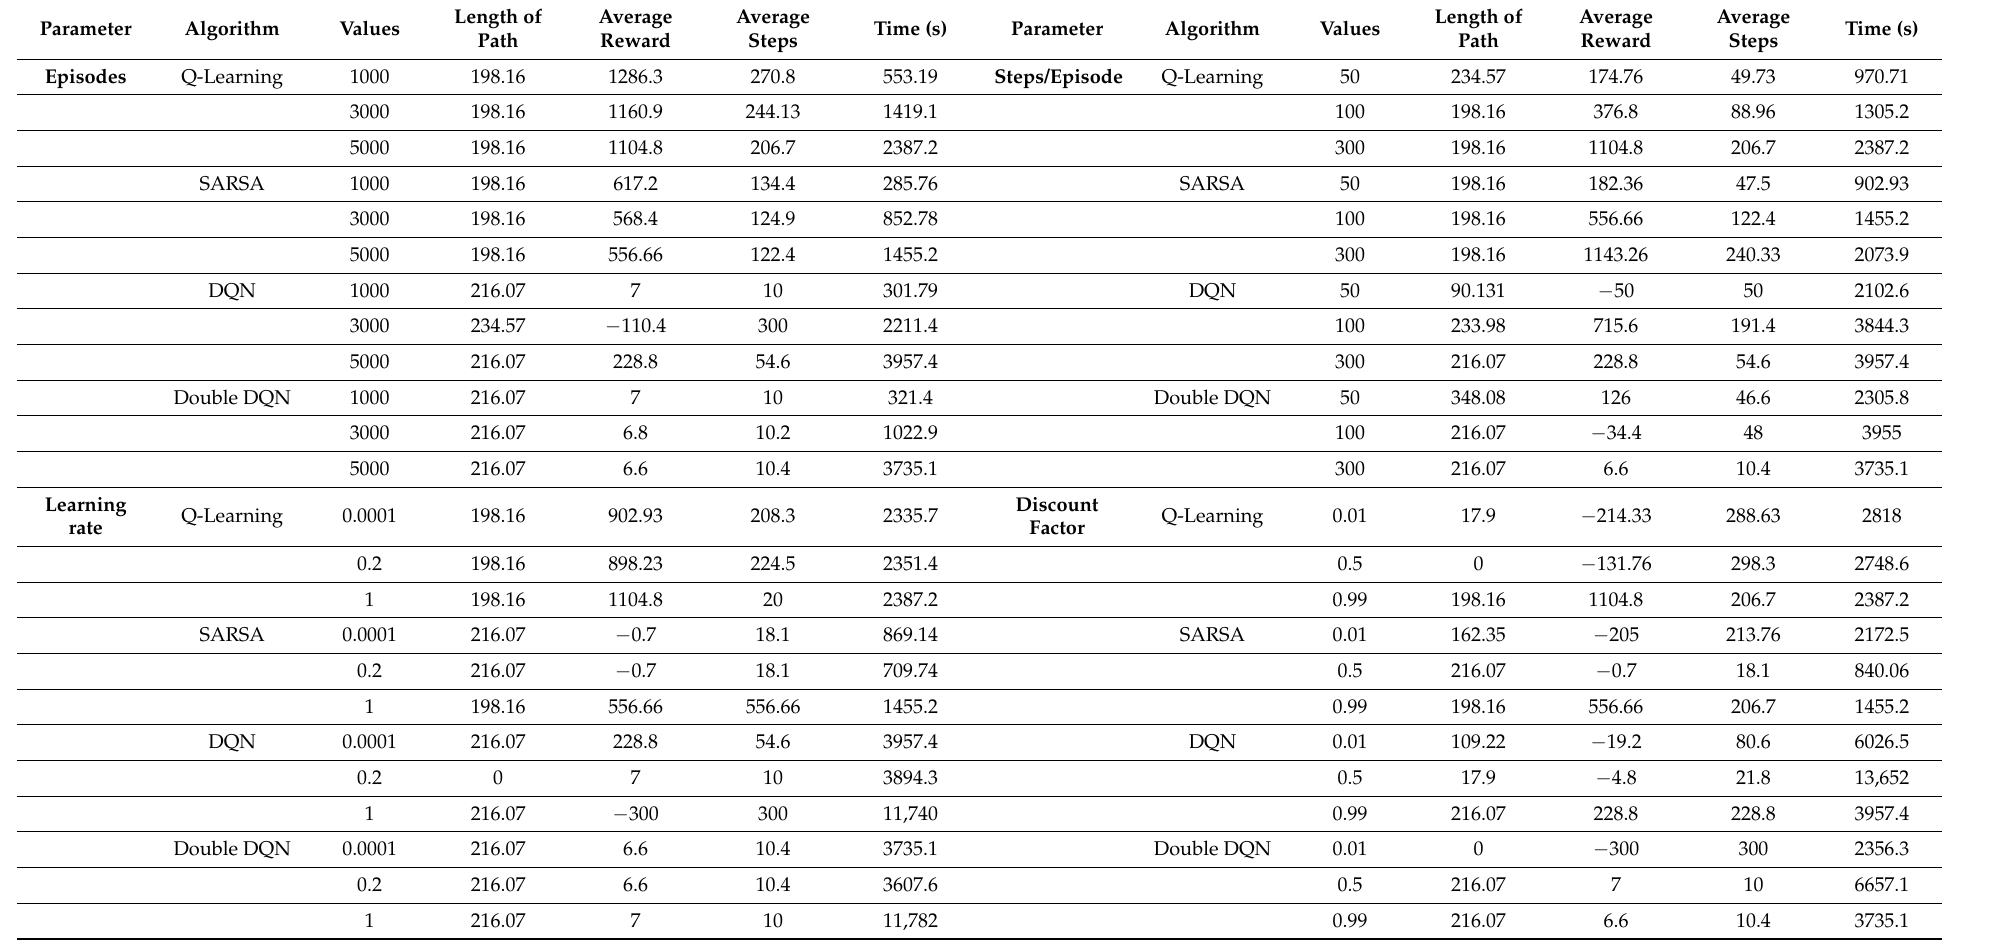
Table A4. Performance Evaluation of Different reinforcement Learning